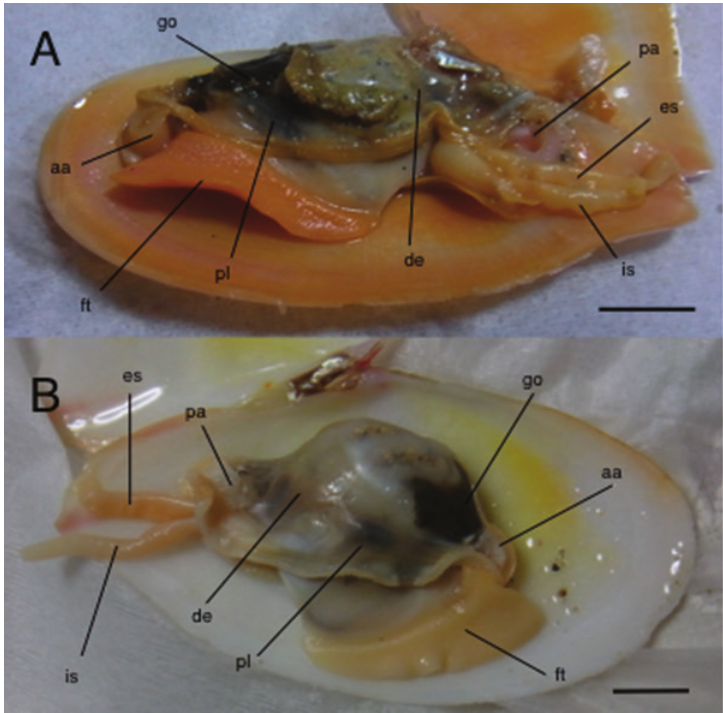
Figure 4. Anatomy of live specimens of Pharaonella amanyu ( A ) and Tonganaella tongana ( B ). Abbrevia- tions: aa, anterior adductor muscle; de, demibranch; es, excurrent siphon; ft, foot; go, gonad; is, incurrent siphon; pa, posterior adductor muscle; pl, palp. Scale bar 10